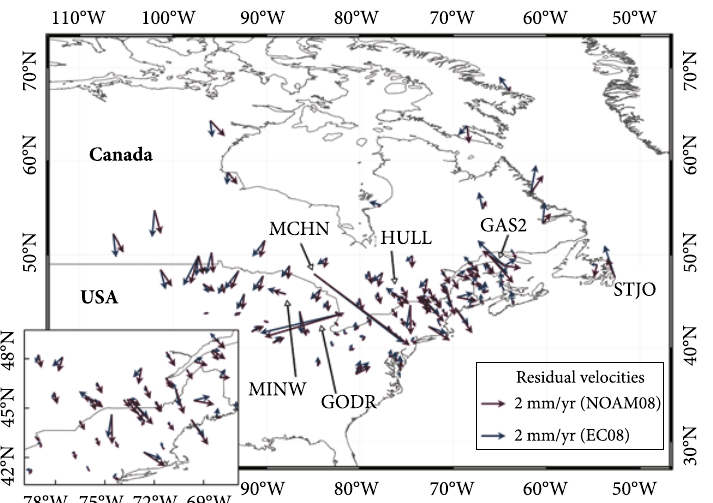
Fig. 4. Intraplate horizontal velocities calculated from Euler poles for the North American plate ITRF 2008 (NOAM08) and from eastern Canada ITRF 2008 (EC08) models illustrated by red and blue arrows, respectively. Although consistent to the first degree, the EC08 intraplate horizontal velocities are generally smaller over the Saint Lawrence River valley (see the inset). This shows the EC08 model can model the horizontal velocity field of this region better than the NOAM08